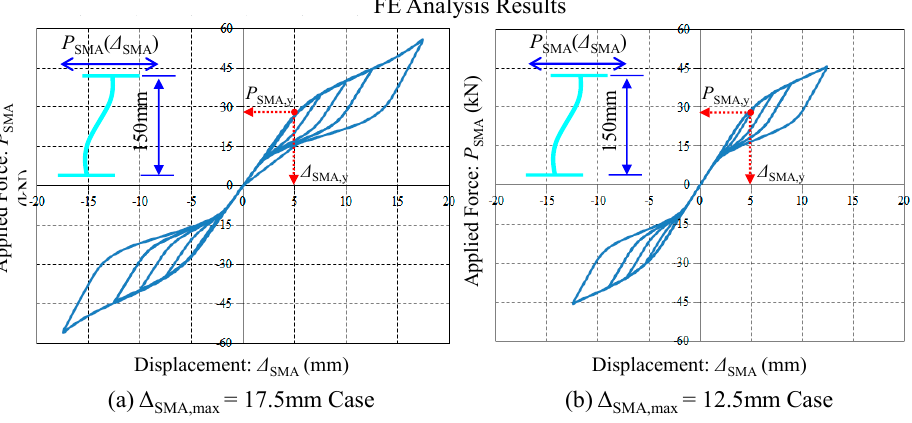
Figure 10. Applied force vs. displacement curves for fixed-end supported SMA bars under transverse end shear force, ( a ): Δ SMA,max = 17.5mm Case; ( b ): Δ SMA,max = 12.5mm